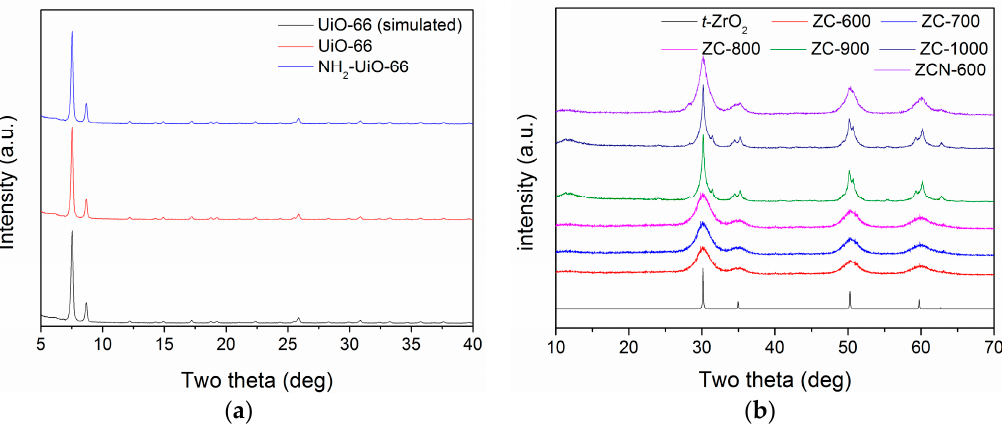
Figure 1. XRD patterns: ( a ) the simulated, virgin, and functionalized UiO-66s; and ( b ) simulated ZrO 2 and ZC composites.